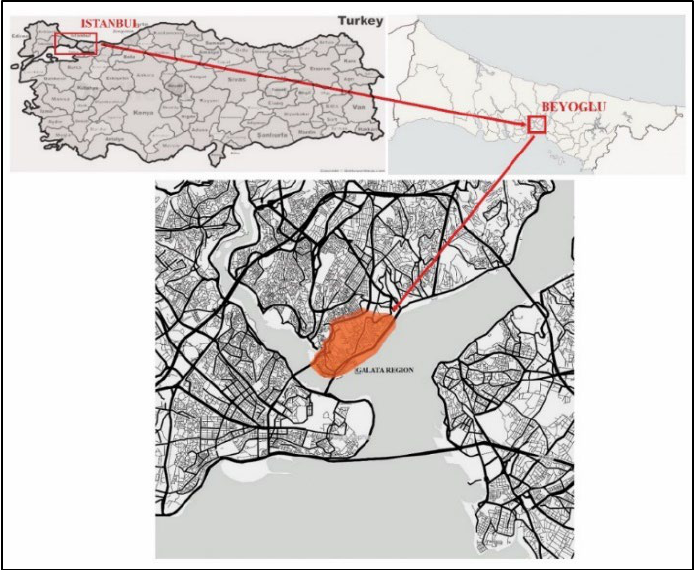
Figure 5 Location of the study area in